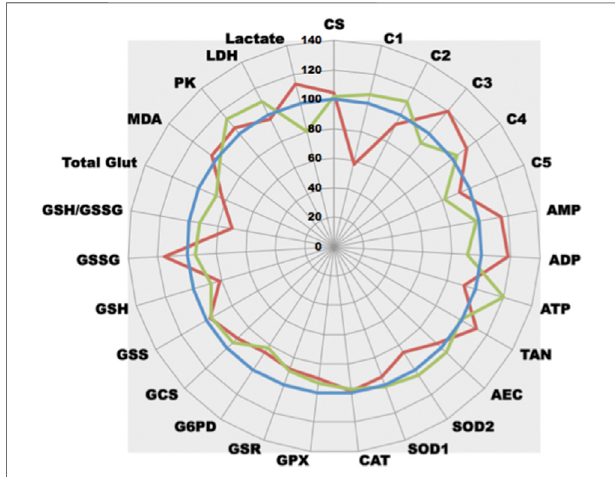
FIGURE 7 | Comparative analysis of the effect of complex I de fi ciency. After blood draw and further white blood cells careful separation, white blood cells of patients were compared (normal patient as control, blue line, control (cid:1) 100%; green line, patient 1; red line, patient 2).